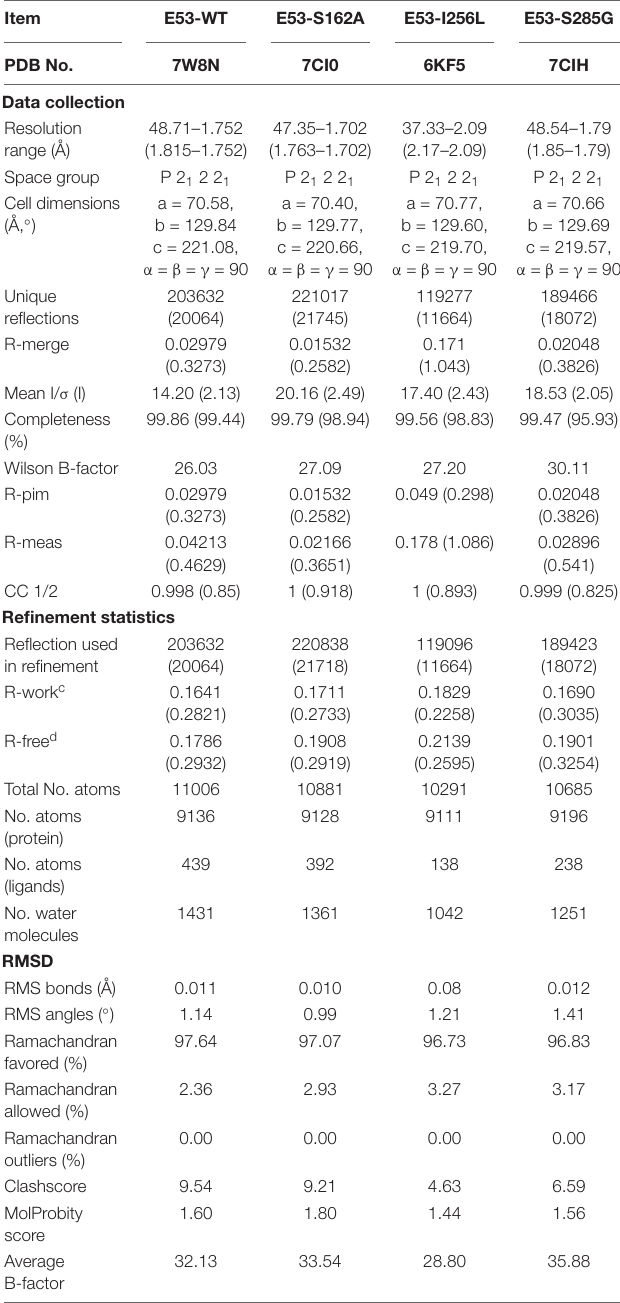
TABLE 1 | Data collection of E53 and its variants.